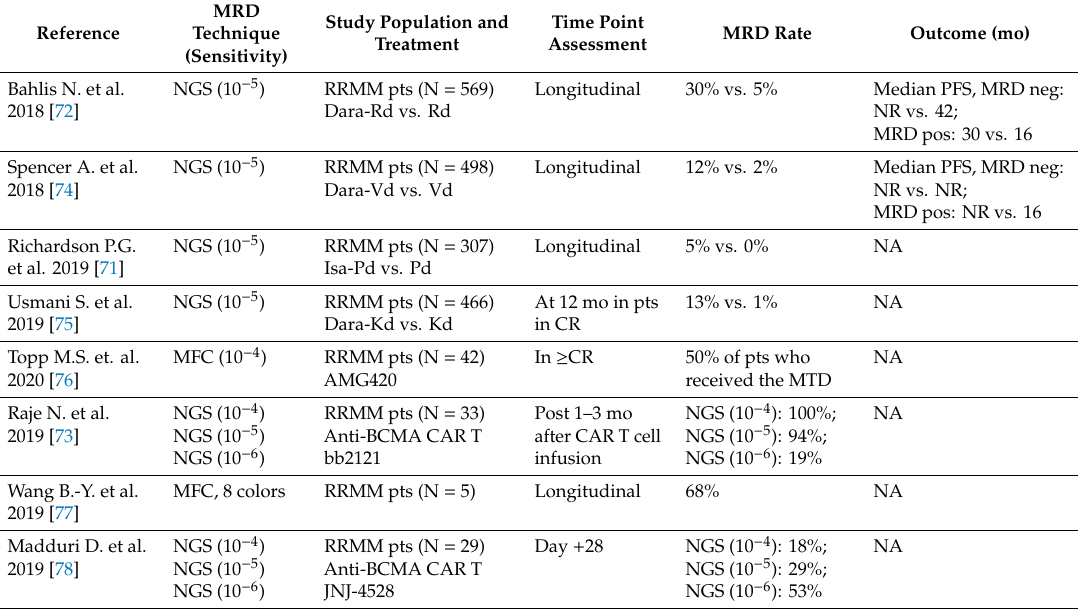
Table 3. RRMM patients treated with novel agents: latest selected studies with MRD